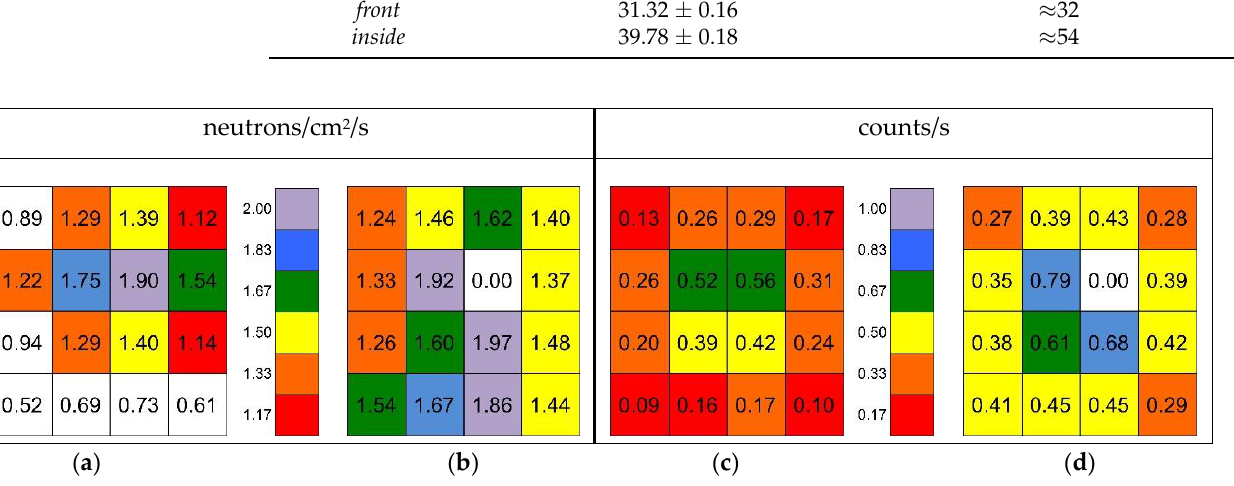
Figure 23. ( a ) Total neutron flux simulated in the top position in correspondence of the 4 × 4 SiLiF array; ( b ) The measured total neutron flux with the 4 × 4 array. ( c ) The simulated neutron counting rates. ( d ) The measured neutron counting rates.